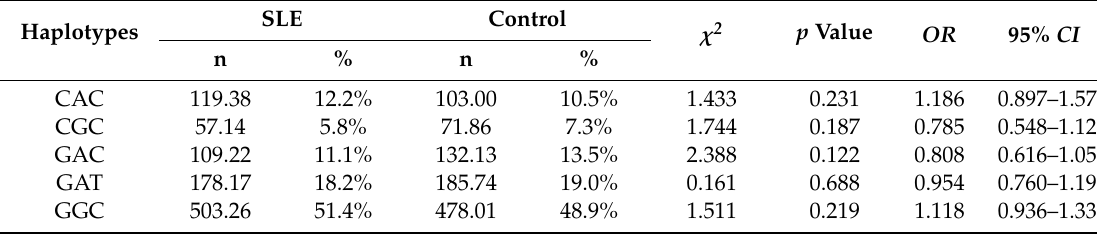
Table 6. Haplotype analysis results among three SNPs in EBI3